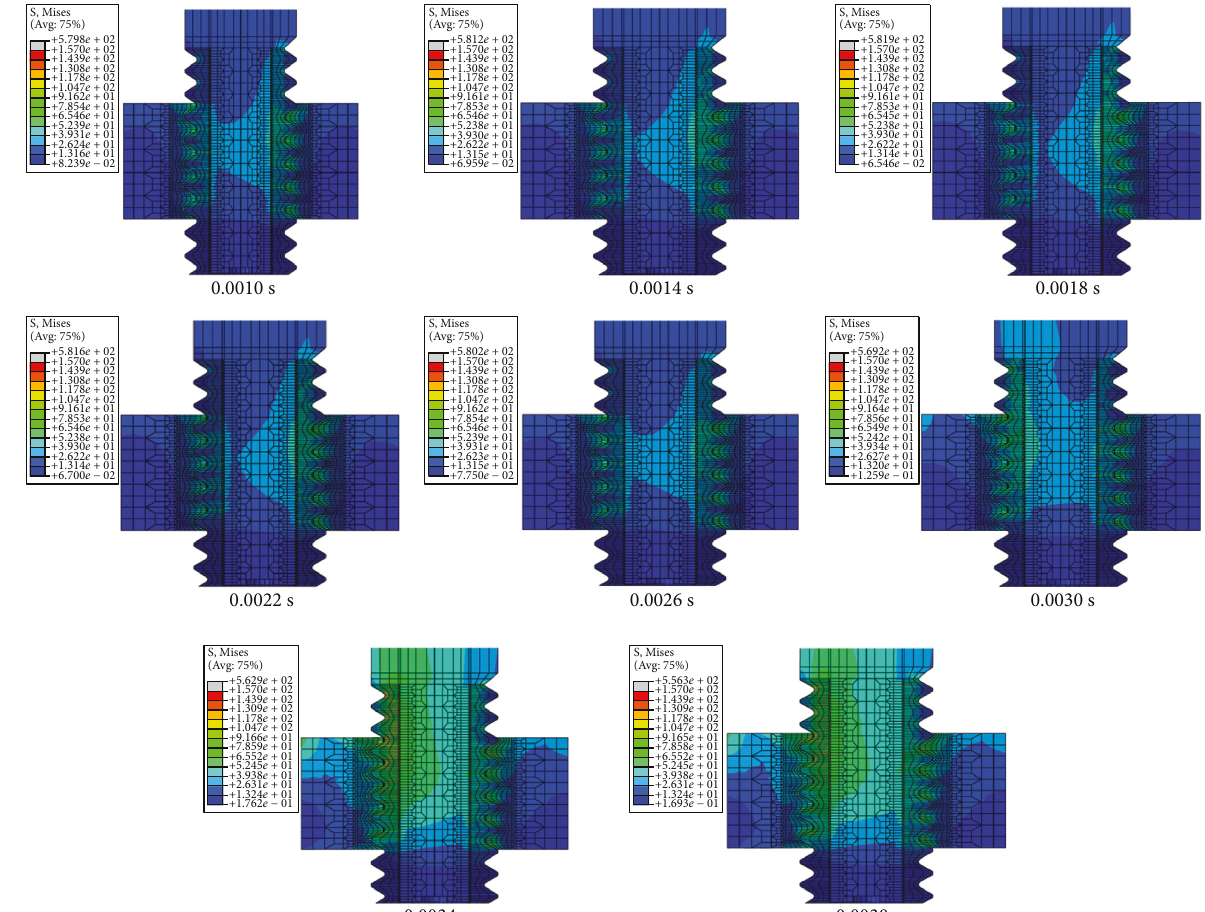
Figure 20: Time-varying graph of bolt section stress under 1.5kN impact load (the loose bolt in six bolts’ flange structure).